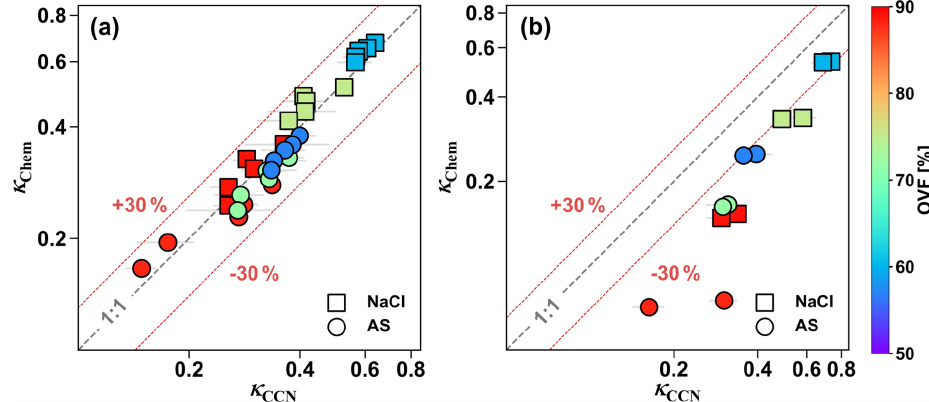
Figure 4. Comparison between κ CCN and κ Chem of (a) inorganic salt mixed with MA, PhMA, SA, PhSA, and PA and (b) inorganic salt mixed with AA and OA. Squares represent NaCl-containing particles, and circles represent AS-containing particles. The color bar indicates